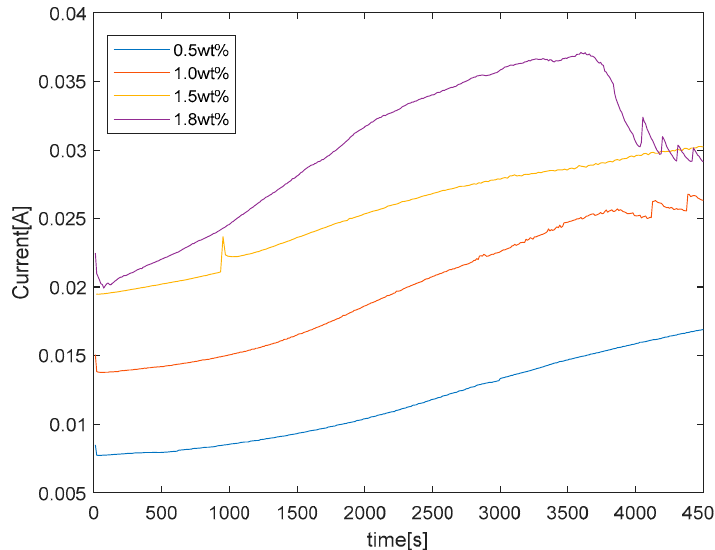
Figure 2. Current according to the electrolyte concentration.